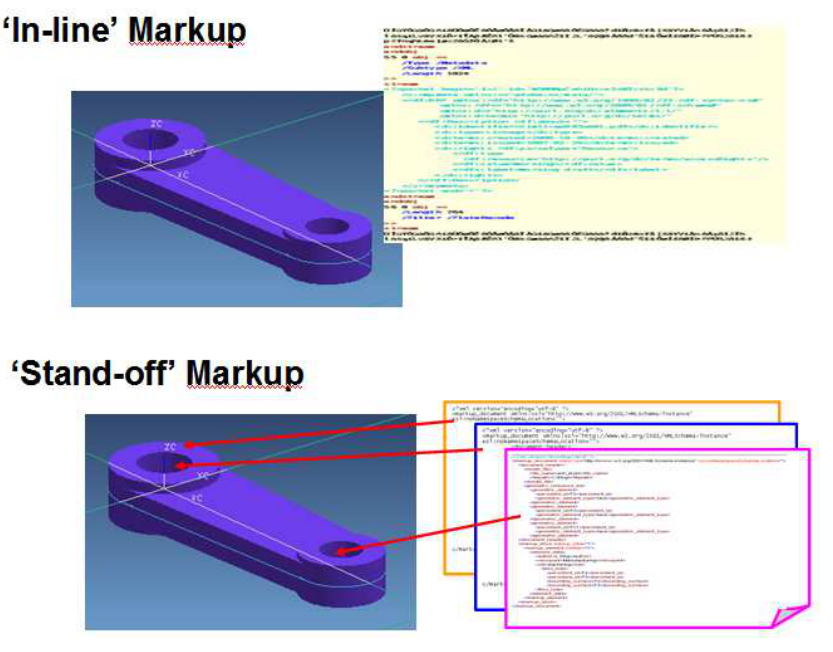
Figure 2. ‘In-line’ and ‘Stand-off’ markup